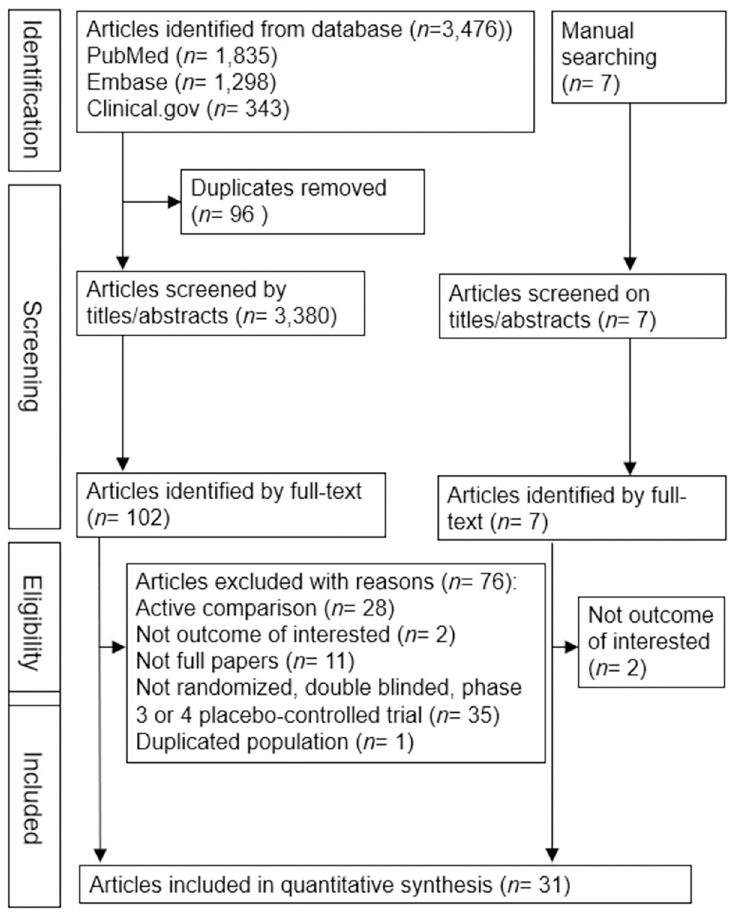
Fig 1. Flowchart of the trial selection